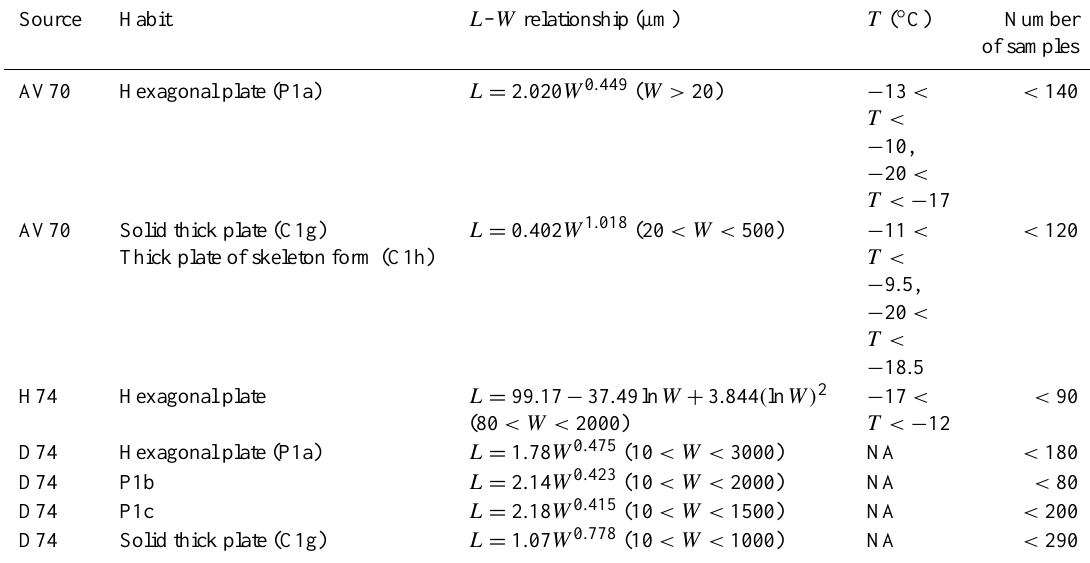
Table 2. Summary of L – W relationships of plate crystals from previous studies: AV70 (Auer and Veal, 1970), H74 (Hobbs et al., 1974), and D74 (Davis, 1974). Ice crystal habit classification (Magono and Lee, 1966) is also shown when the original work indicated habit. NA indicates that corresponding information is not